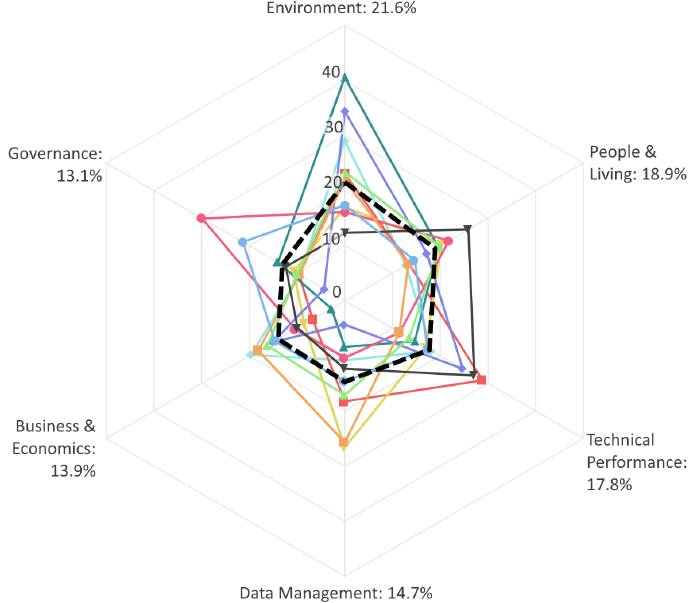
Figure 4. Radar chart showing KPI theme weightings calculated from the DCE. The black dashed line shows the mean result from all respondents, while the solid coloured lines are a sample of results from individual